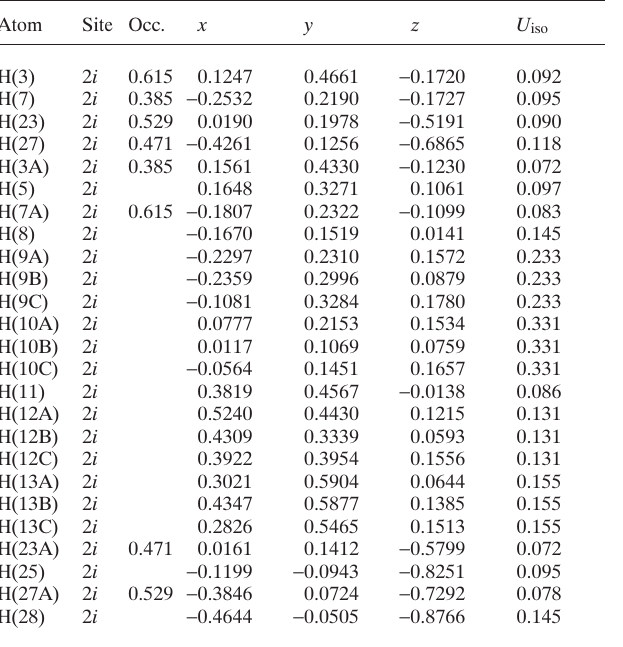
Table 2. Atomic coordinates and displacement parameters (in Å 2 )